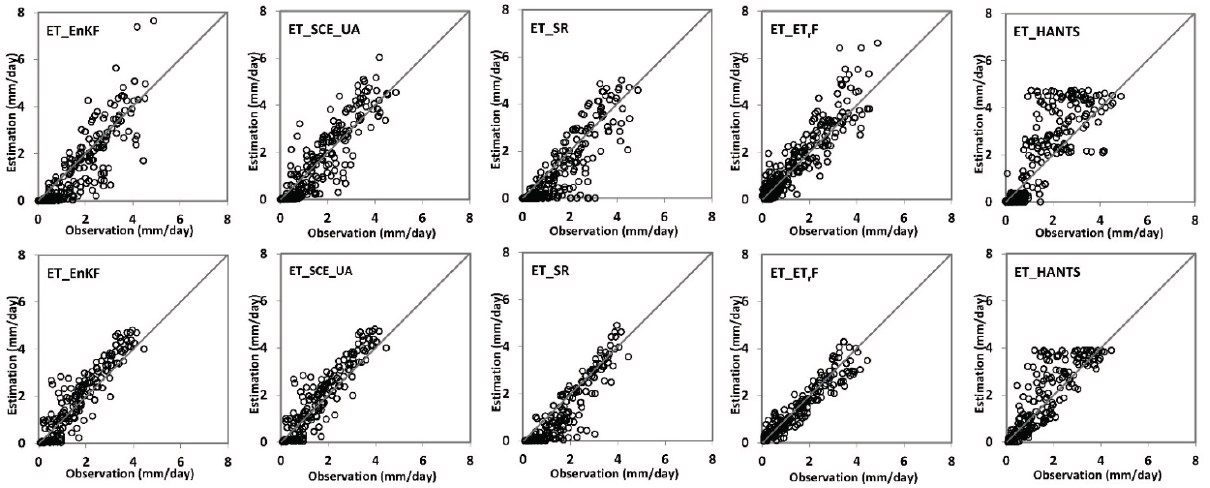
Figure 5. The comparisons of cloudy-day ET between the model estimations and observations. (Guantao site result ( top ); Arou site result ( bottom